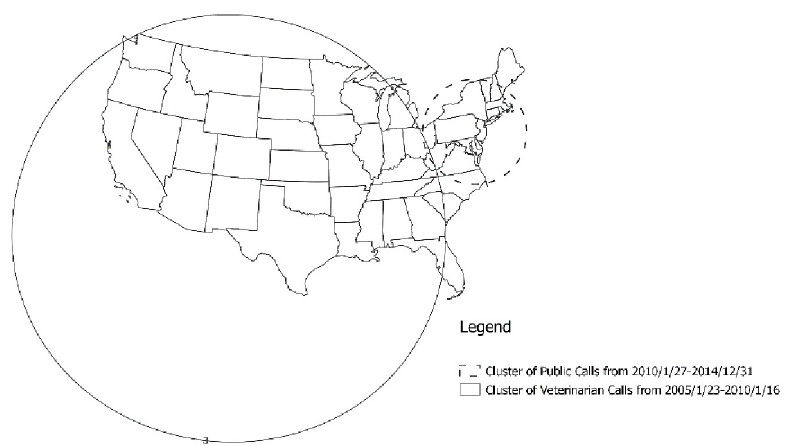
Fig 4. Results of the spatio-temporal scan of the entire study period (2005–2014), clusters with solid lines represent higher than expected veterinarian calls and dashed clusters represent higher than expected public